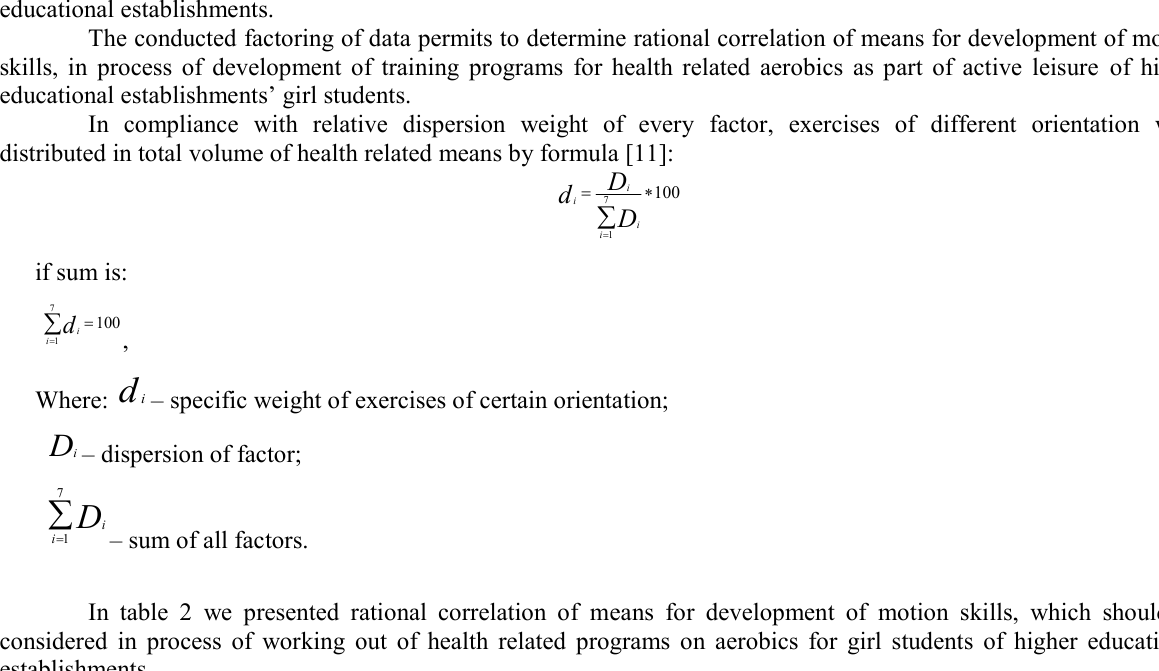
Rational correlation of means for development of motion skills of higher educational establishments’ girl students (%) Motion skills Correlation of means (%) Power endurance of girdle muscles 16.21 Dynamic strength 12.94 Static endurance of girdle muscles 17.78 Aerobic endurance 19.88 Speed power endurance of abdomen muscles 9.56 Flexibility 9.91 Quickness